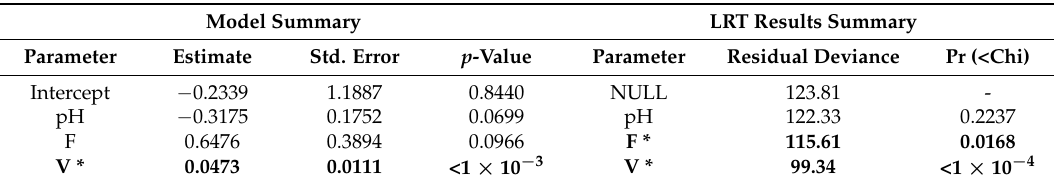
Table 4. Summary of the Evangeline LR model (significant variables at p ≤ 0.05 are shown in bold and asterisk).